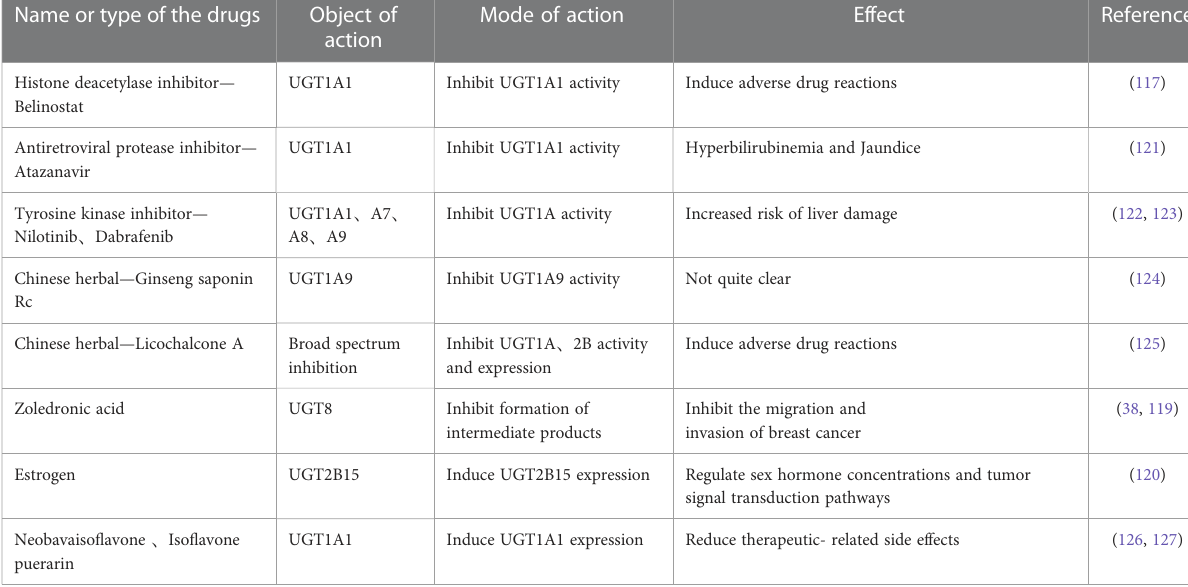
TABLE 4 Summary of inhibitors and inducers of